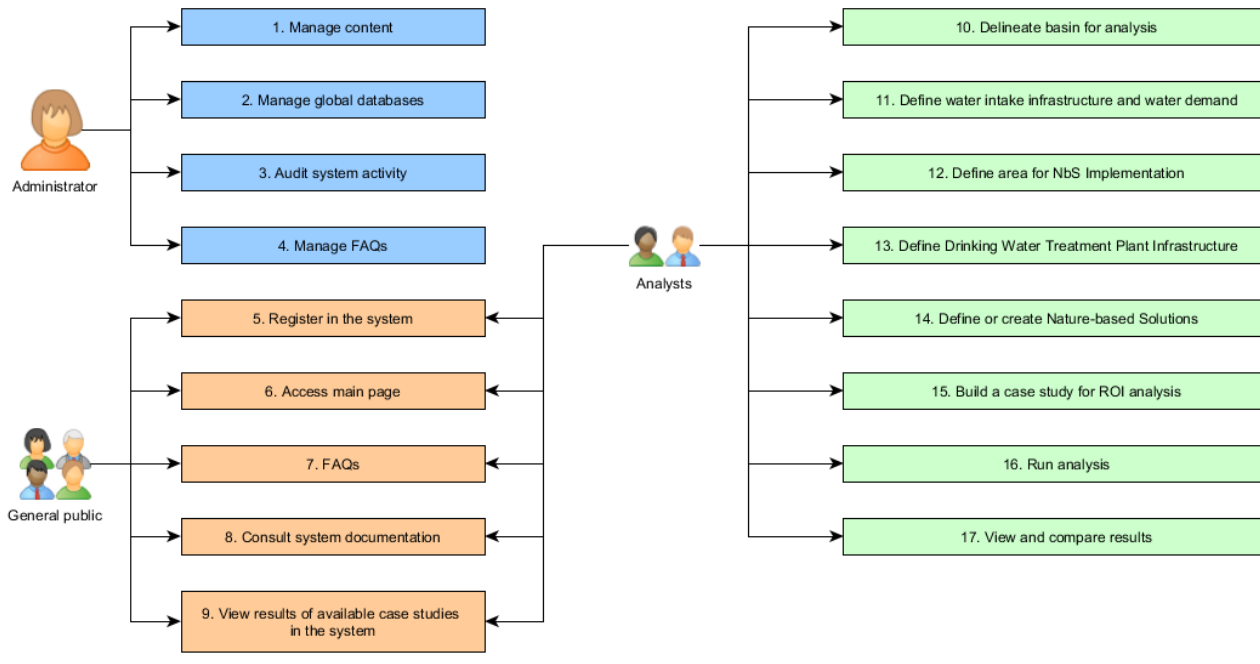
Figure 1. Main functionalities identified for each of the WaterProof user types.